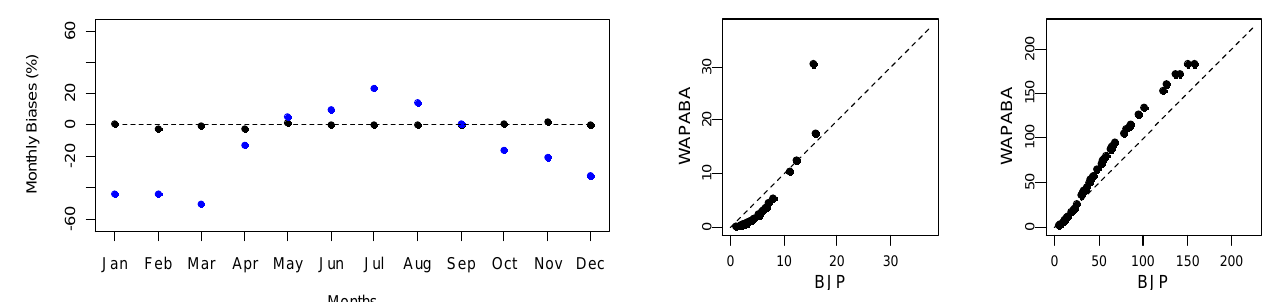
520 Fig. 8. WAPABA predictions vs. the medians of post-processed pre- dictions produced by method A in Lake Eildon for the months of Figure 8: WAPABA predictions vs. the medians of post-processed predictions produced by method A 521 February (left) and July (right), showing the example of non-linear in Lake Eildon for months of February (left) and July (right), showing the example of non-linear error 522 error corrections by the BJP post-processor. corrections by the BJP post-processor. 523